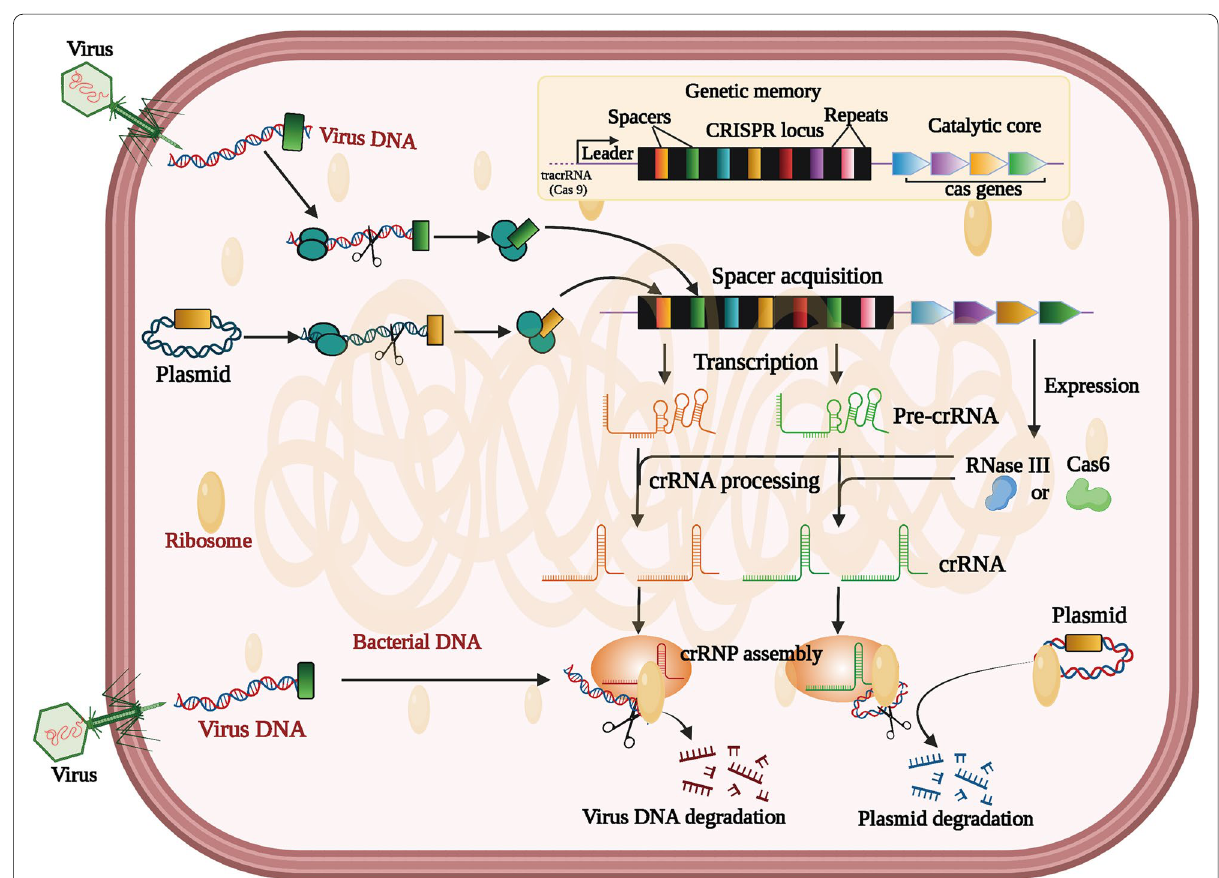
Fig. 1 Overview of the CRISPR-Cas systems. CRISPR-Cas systems including leader, spacer and repeats are alternately arranged to form R-S structure and cas locus. The function of CRISPR-Cas systems include three stages: spacer acquisition, crRNA processing and assembly, and target degradation. The first step occurs after the foreign DNA sequence invades bacteria, and the bacterial genome intercepts a sequence from the invaded DNA fragment and integrates it into its CRISPR sequence to become a new spacer. Then, CRISPR clusters are transcribed into pre-crRNA under the initiation of the leader and further processed into mature small crRNAs. The mature crRNAs and Cas proteins assemble to form a CRISPR ribonucleoprotein (crRNP) complex. Once the same foreign DNA invades, the Cas protein complex binds, cleaves and degrades it by the base-pair